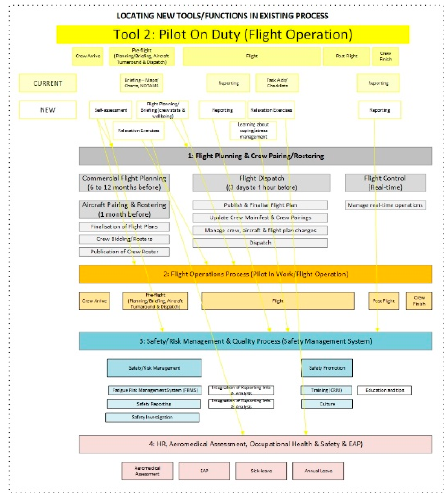
Figure A6. Pilot off duty: Tool 2 and process, Tool 2 (pilot on duty). Figure A6. Pilot o ff duty: Tool 2 and process, Tool 2 (pilot on duty).